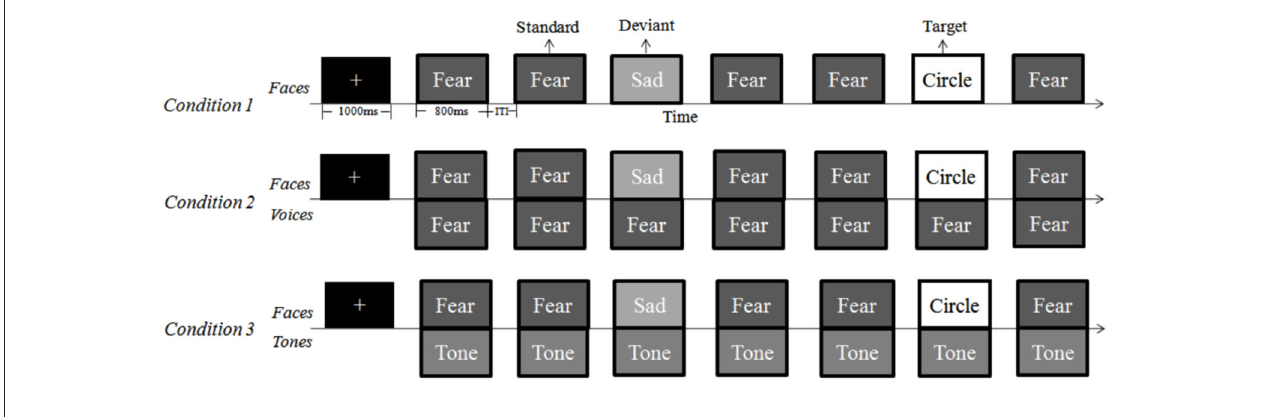
face-voice and face-tone conditions, the visual and auditory stimuli were synchronized. From top to bottom: face-only, face-voice,